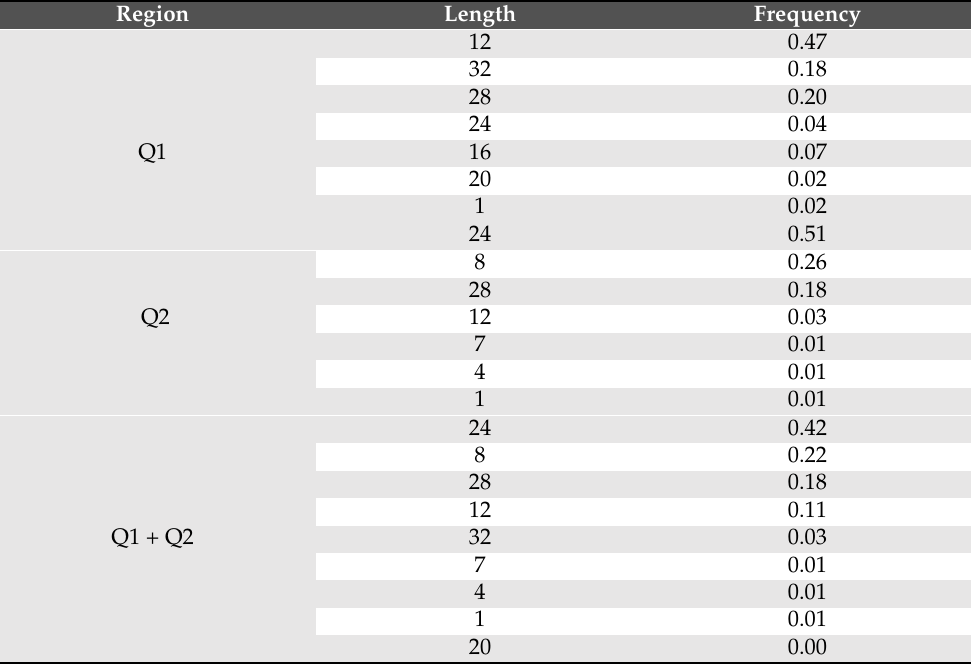
Table 3. Length distribution of the deletions in the regions Q1 and